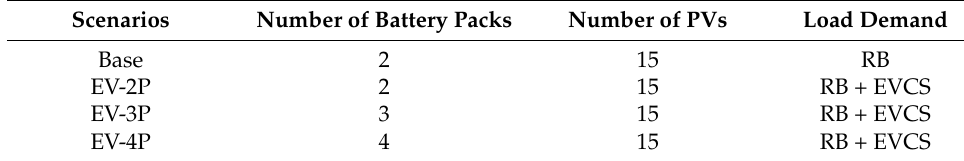
Table 1. The defined scenarios in this study. Table 2. Second life battery pack specifications [22].